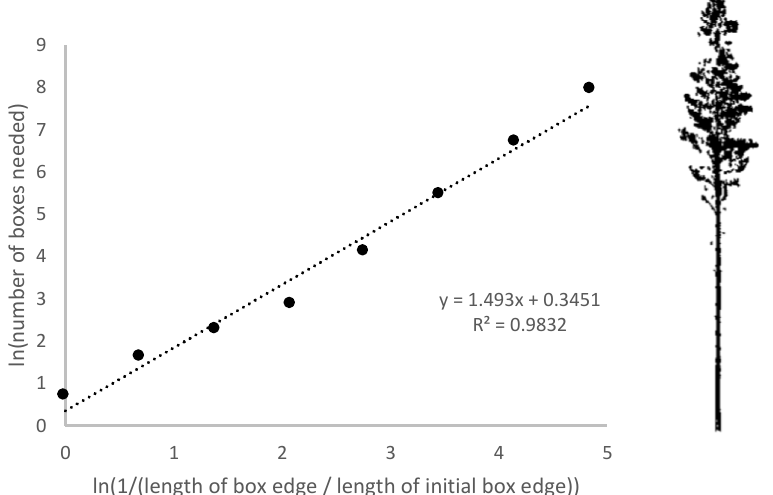
Figure 4. Box dimension (D b ) is the slope of the fitted straight line ( x = 1.493). Modified after Figure 1 in Seidel [32].